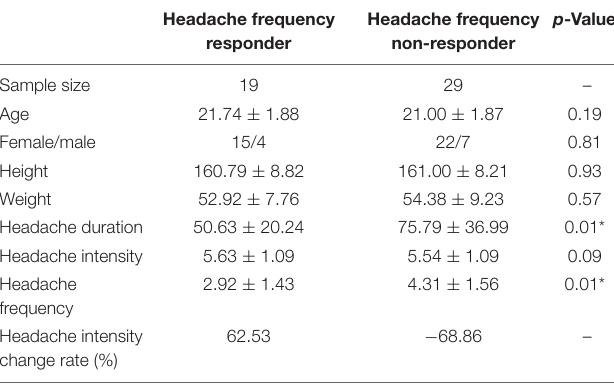
TABLE 3 | Headache frequency responder, patient with significant headache frequency improvement; non-responder, patient with nonsignificant headache frequency